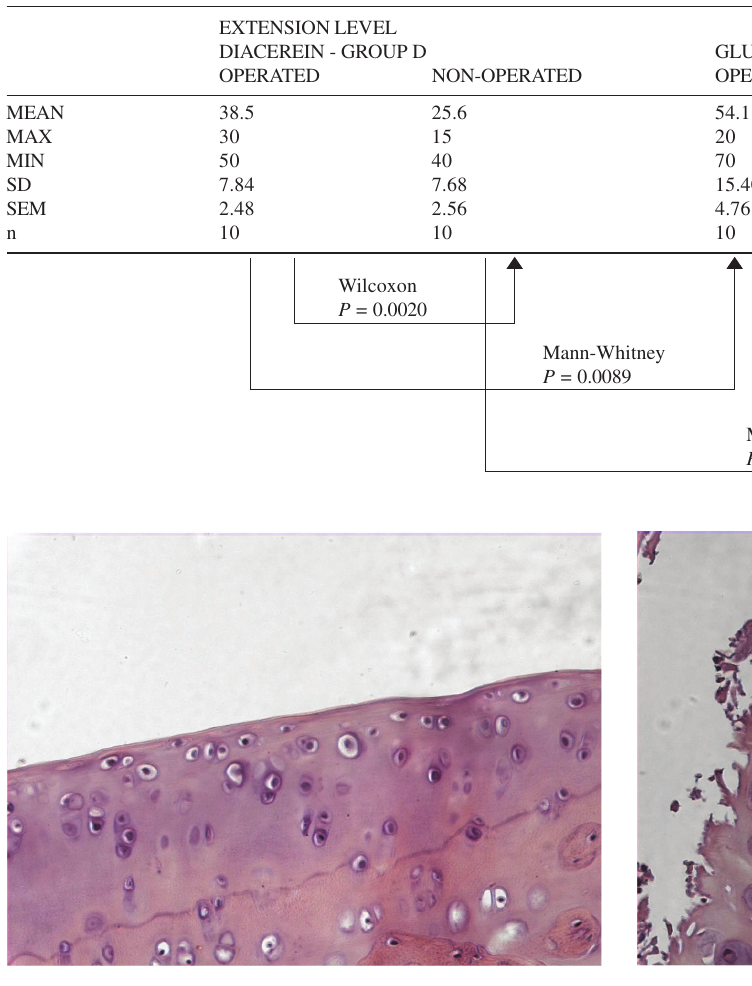
Figure 2 - Diacerin group, case 1, Nonoperated knee (left). Mankin Score = 2 Figure 3 - Glucosamine group, case 5, operated knee (right). mankin score = 9